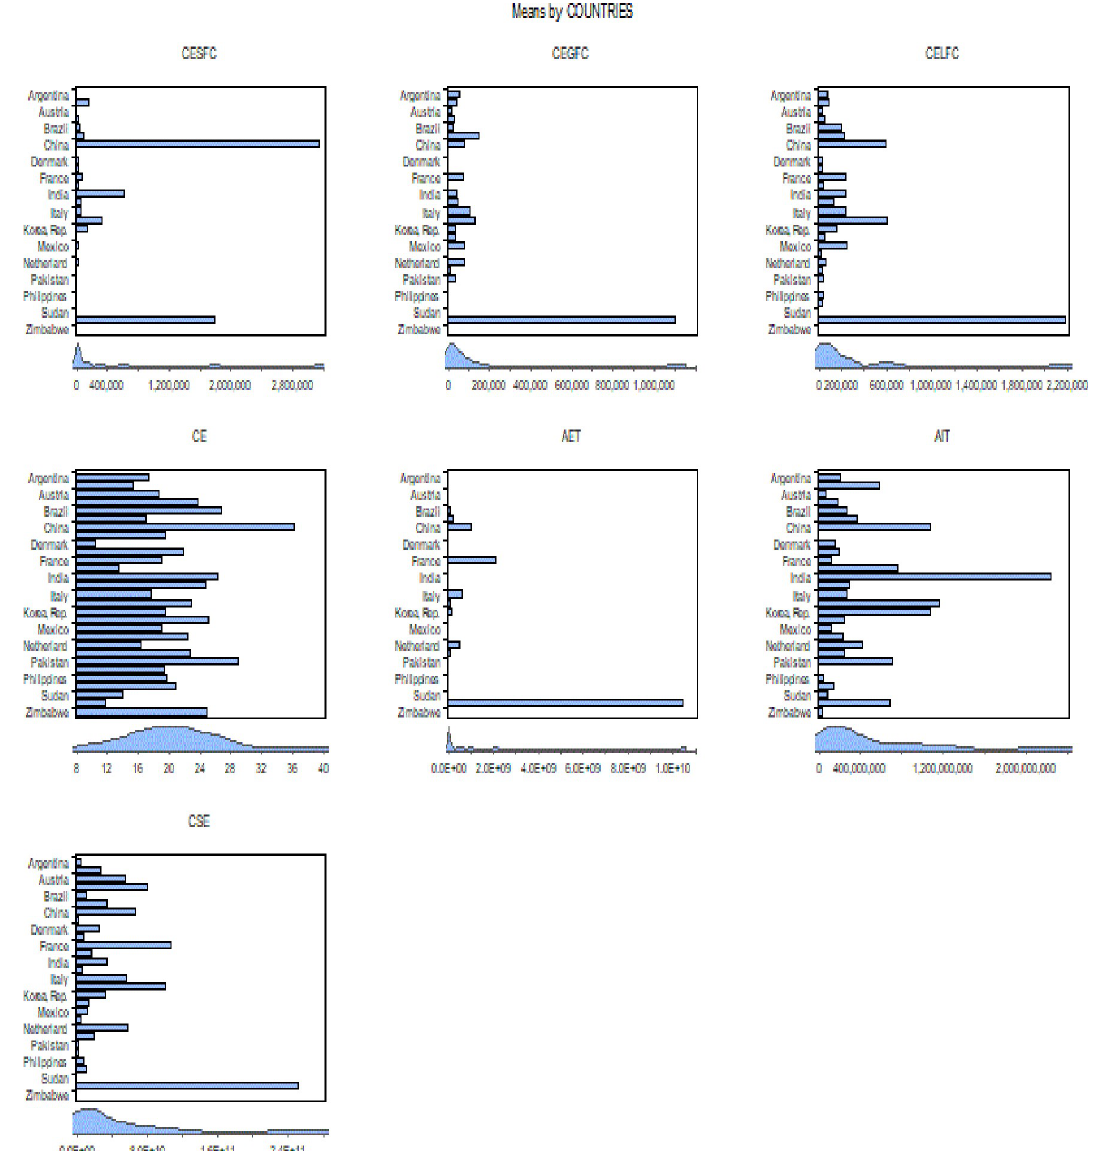
Fig 3. Highest mean valuation of pollutant emission by 29 countries. Source: Authors’ amplification.